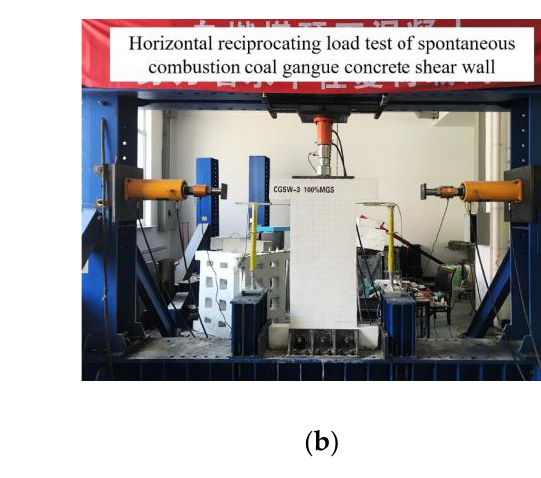
Figure 6. Test setup ( a ) Schematic diagram ( b ) Practice diagram.